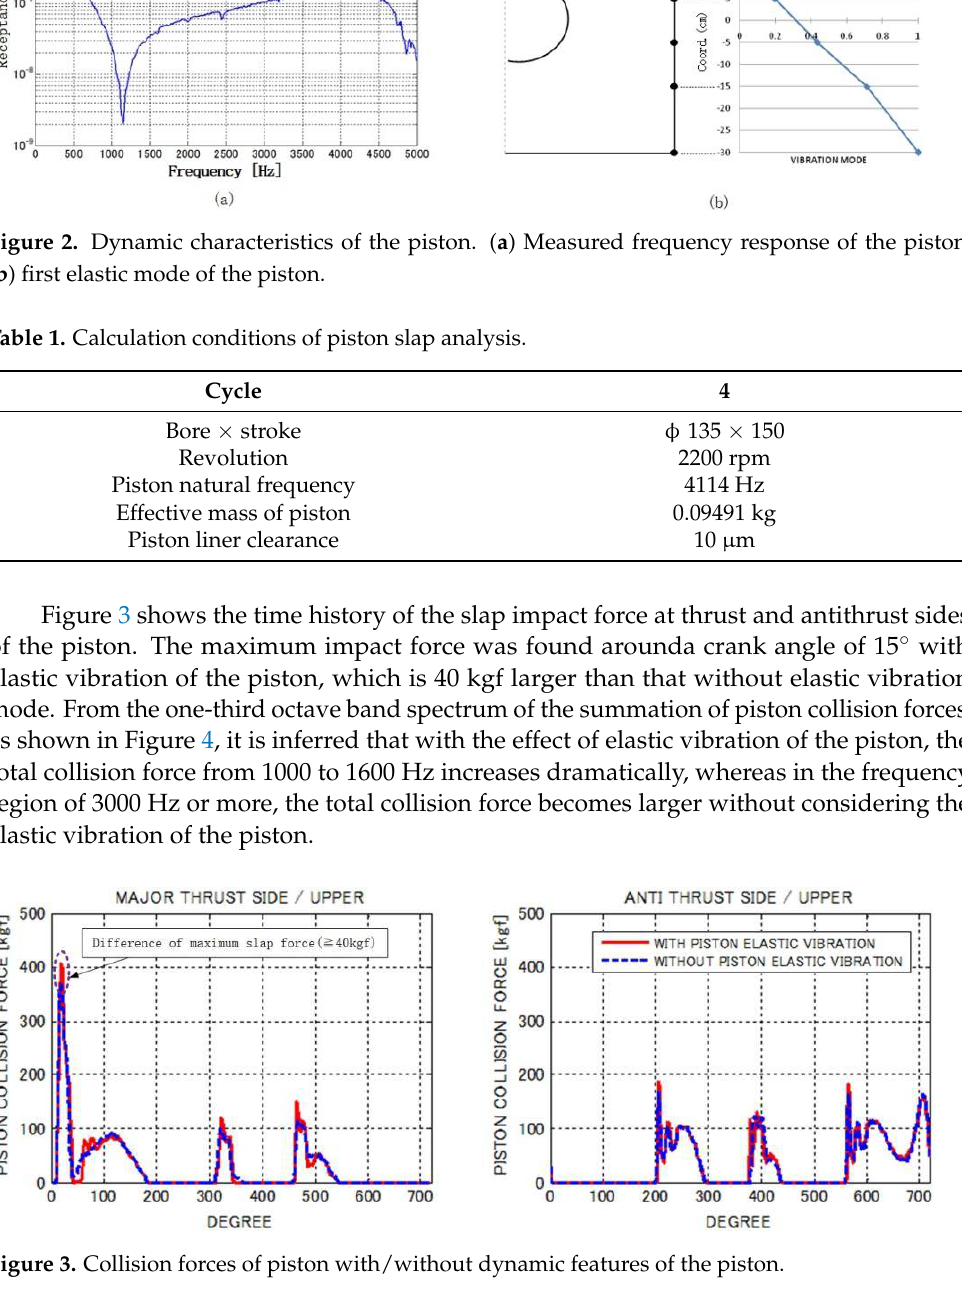
Figure 4. One-third octave band spectrum of the summation of piston collision forces with/without dynamic features of the piston. The contour line of collision force distribution at the thrust and antithrust sides of the piston at different crank angles is shown in Figure 5. With the effect of elastic vibra- tion of the piston, there are collision forces at the lower part of the thrust side around the crank angle of 350 ° . However, without consideration of the elastic vibration of the piston, the collision force at the same position and crank angle is less than 1 kgf. Generally, the collision force at the bottom of the thrust side skirt becomes smaller without considera- tion of piston elastic vibration.